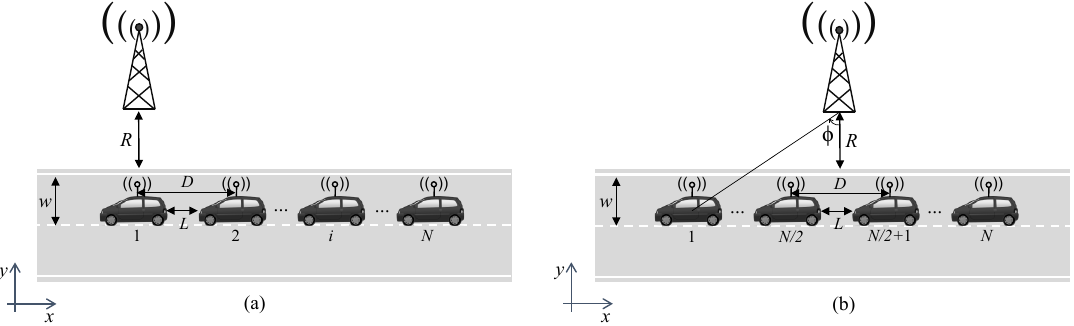
Figure 1. Scenarios under consideration comprising a platoon of vehicles assisted by a base station (BS). ( a ) Asymmetric case, where the BS is aligned with the antenna of the platoon leader. ( b ) Symmetric case, where the line connecting the BS with the platoon leader forms an angle φ with the perpendicular line, so that the BS is aligned with the platoon middle